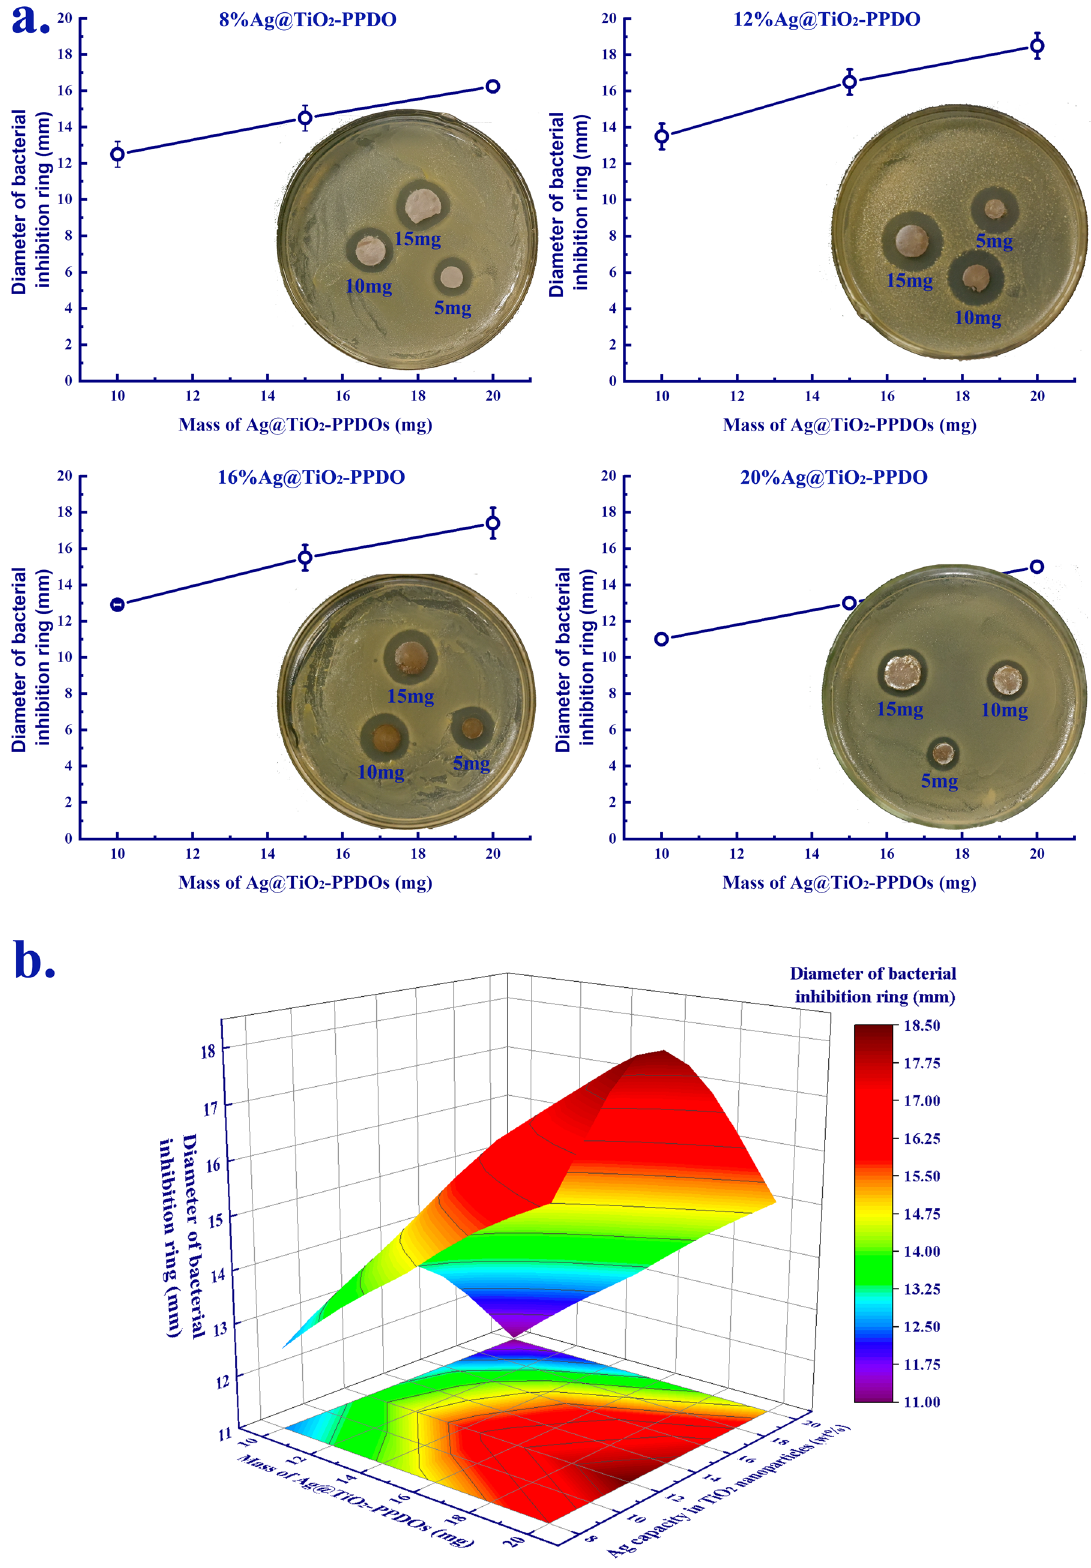
Figure 4. ( a ) Bacteriostatic zone diameter of Ag@TiO 2 -PPDOs with different dosage; ( b ) Correlations of bacteriostatic zone diameter with Ag loading contents and